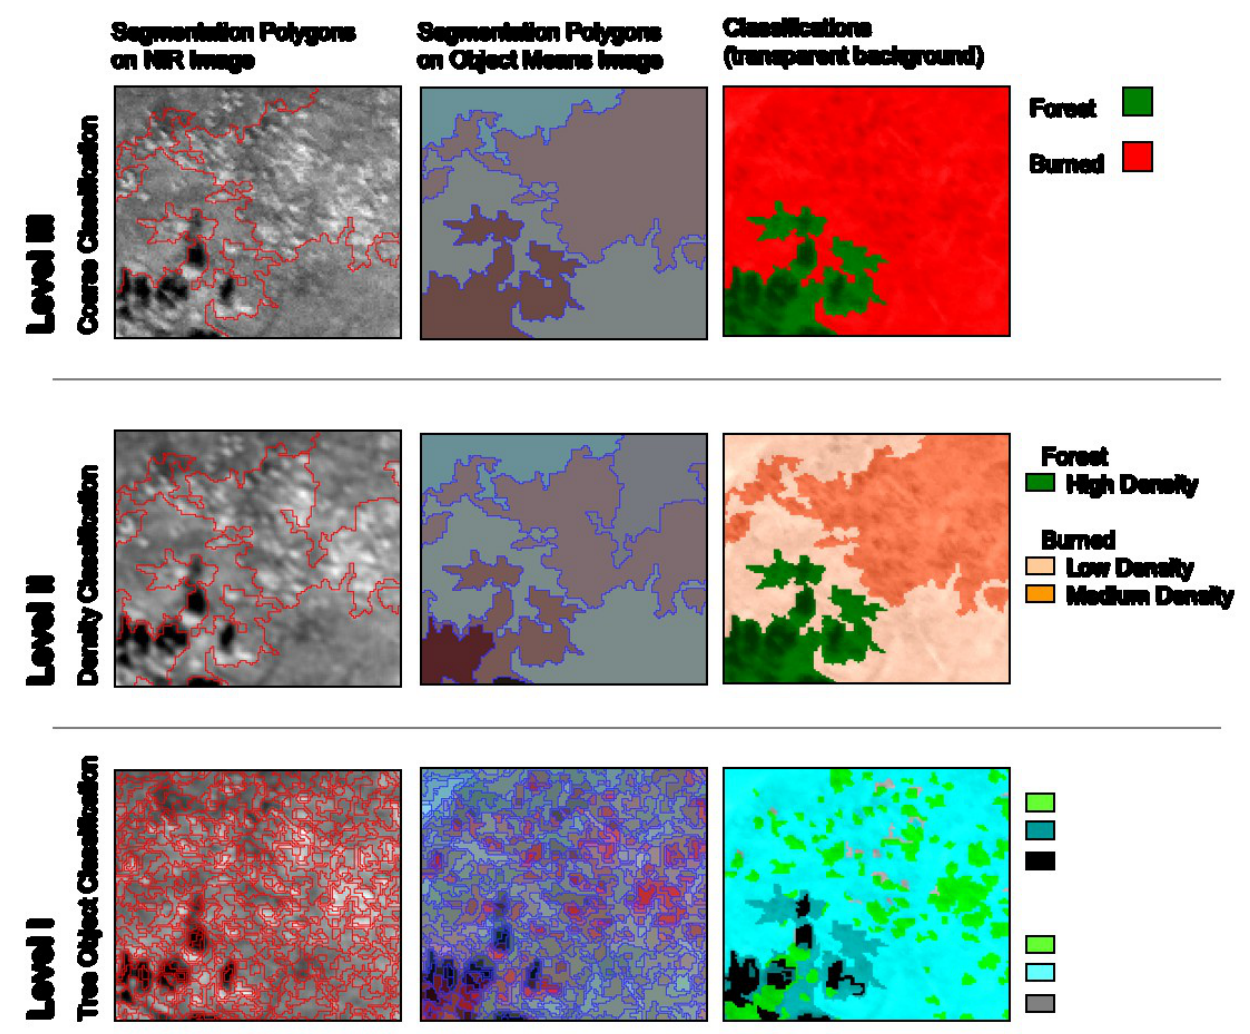
Figure 7. Close-up of the classified imagery at the three hierarchical